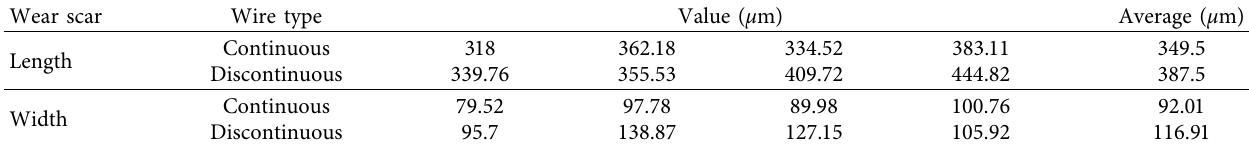
Table 2: Continuous and discontinuous wire wear scar length and width and average